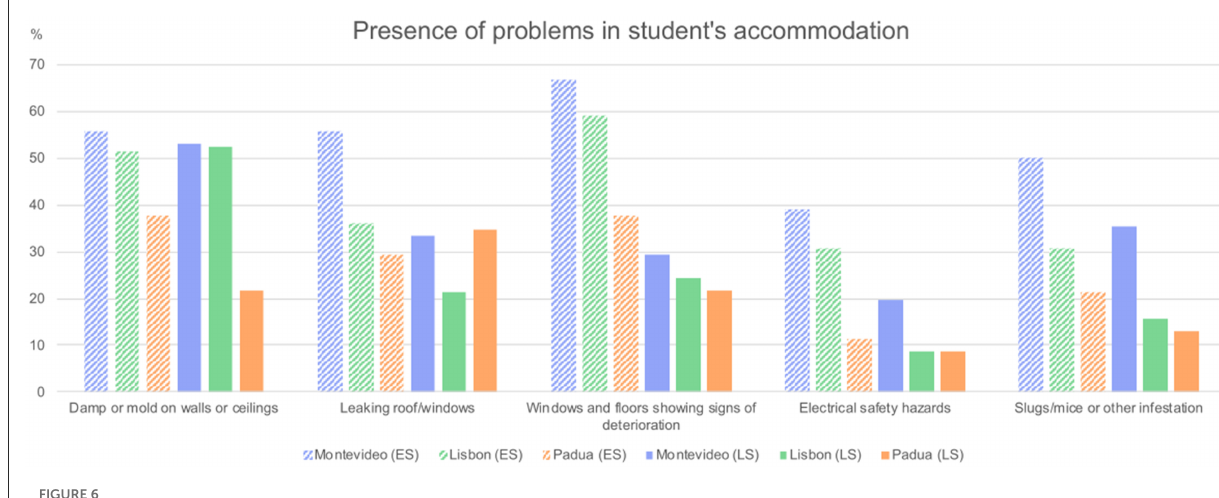
FIGURE6 Presence of problems in student accommodation in each population.